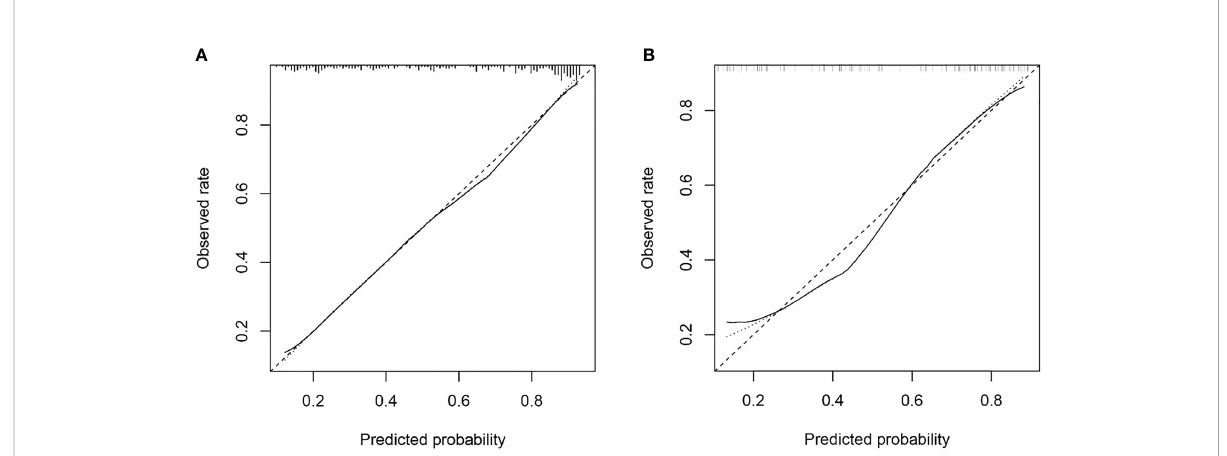
FIGURE 6 The calibration curve of nomogram in the primary dataset (A) and validation dataset (B) showed good agreement between the predicted probability of lymphovascular invasion (LVI) by the nomogram and actual probability of LVI after surgery. Calibration curves depict the calibration of each model in terms of the agreement between the predicted risks of LVI and observed rate of LVI. The y-axis represents the actual. The x-axis represents the predicted LVI prevalence. The diagonal dotted line represents a perfect prediction by an ideal model. The solid line represents the performance of the nomogram, of which a closer fi t to the diagonal dotted line represents a better